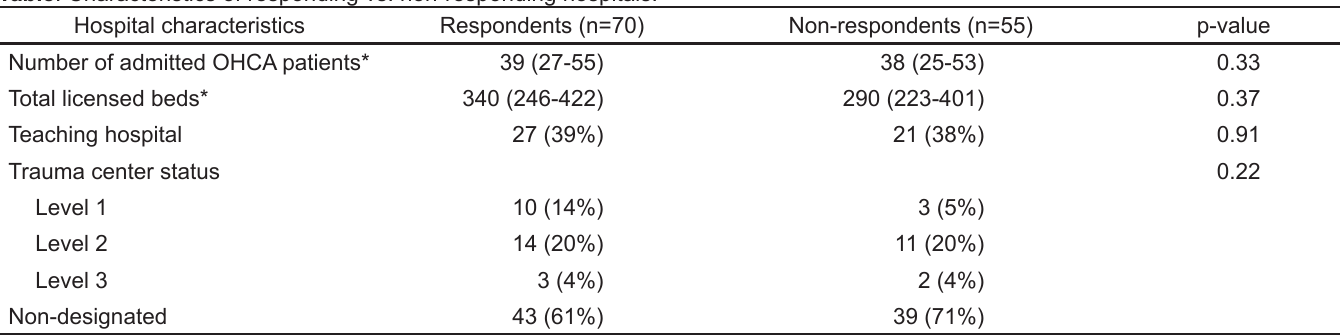
Table . Characteristics of responding vs. non-responding